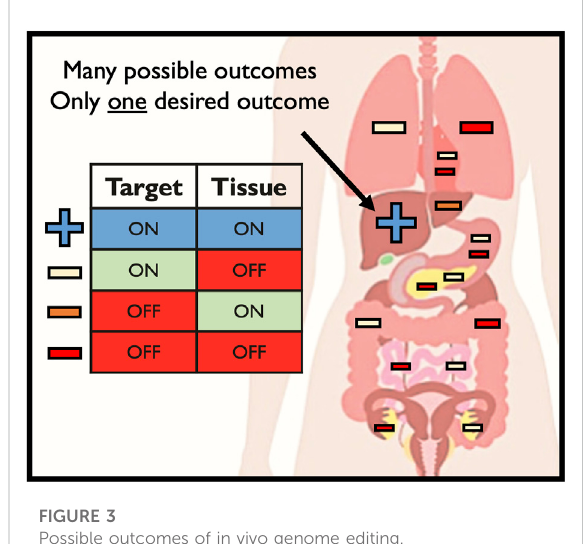
FIGURE 3 Possible outcomes of in vivo genome